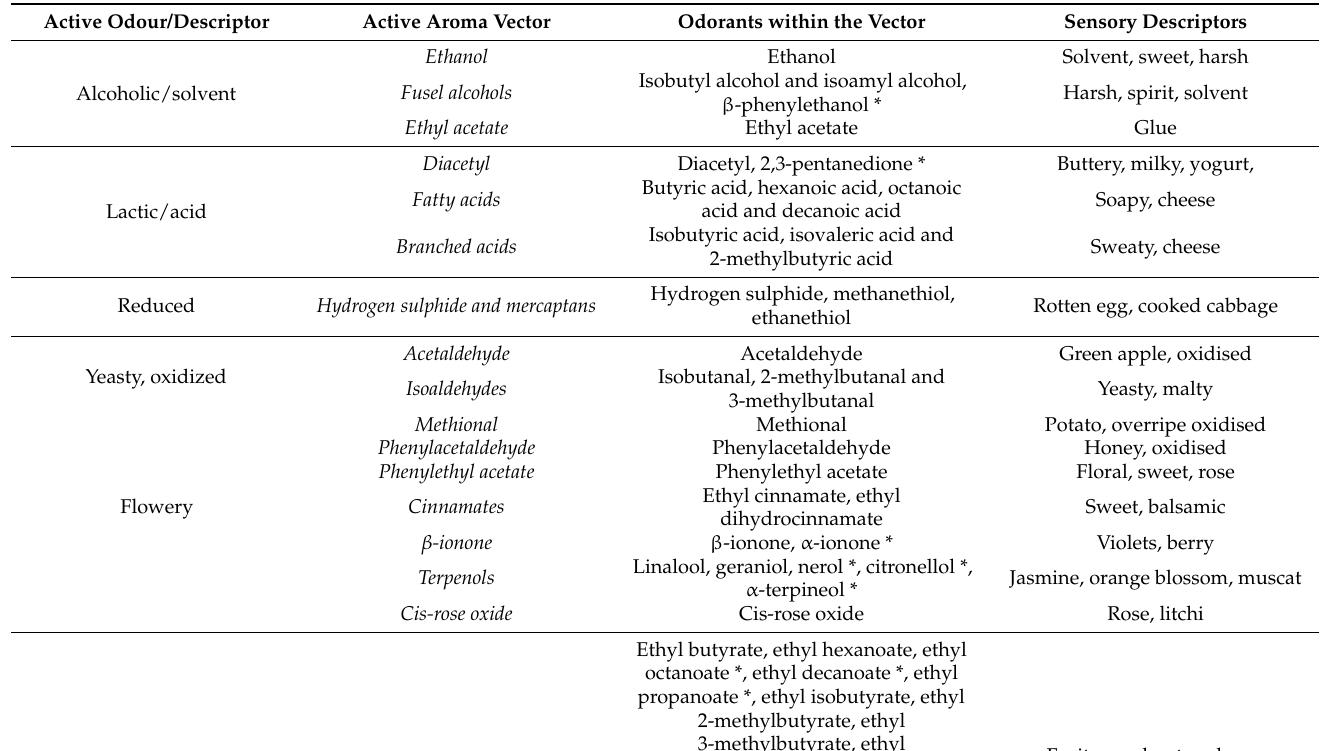
Table 1. Odorant composition of the updated active vectors and active aroma descriptors of